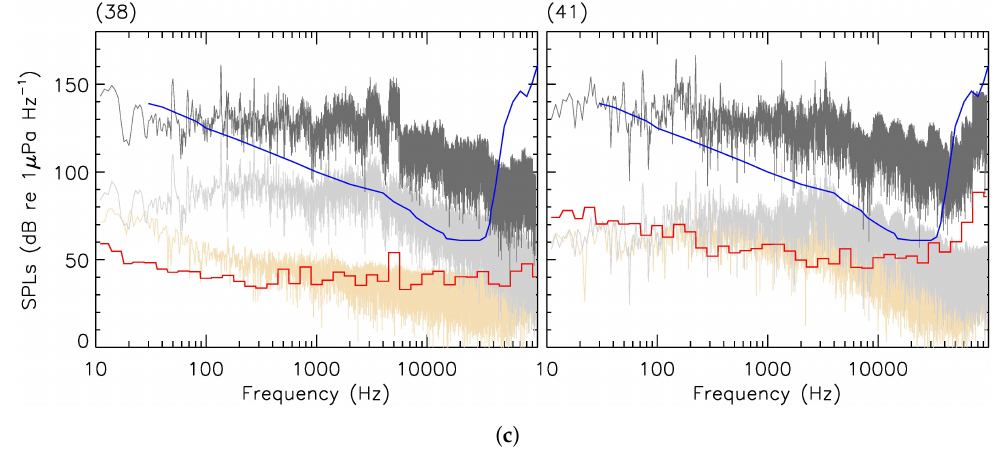
Figure 4. Examples of sound pressure levels (dB re 1 µ Pa Hz − 1 ) in the frequency domain for events of isolated recreational vessel during the 2021–2022 campaigns along the Saguenay River. Light grey: received levels at the hydrophone for CPA occurrences listed in Table 1. Red: transmission loss along the vessel-to-hydrophone transect as predicted by the parabolic equation solver ( f < f 0.5 ) and the ray-tracing approach ( f ≥ f 0.5 ). Dark grey: monopole source levels of the targeted vessel obtained from the passive SONAR equation (Equation (A3)). Blue: beluga hearing audiogram [45]. Wheat: ambient levels during the 10 min duration (see examples in Figure 2) centred on CPA occurrences. Panels’ numbers refer to the vessels’ labels in Table 1. ( a ) Events 12, 18, 20, and 29; ( b ) events 31, 32, 33, and 37; ( c ) events 38 and